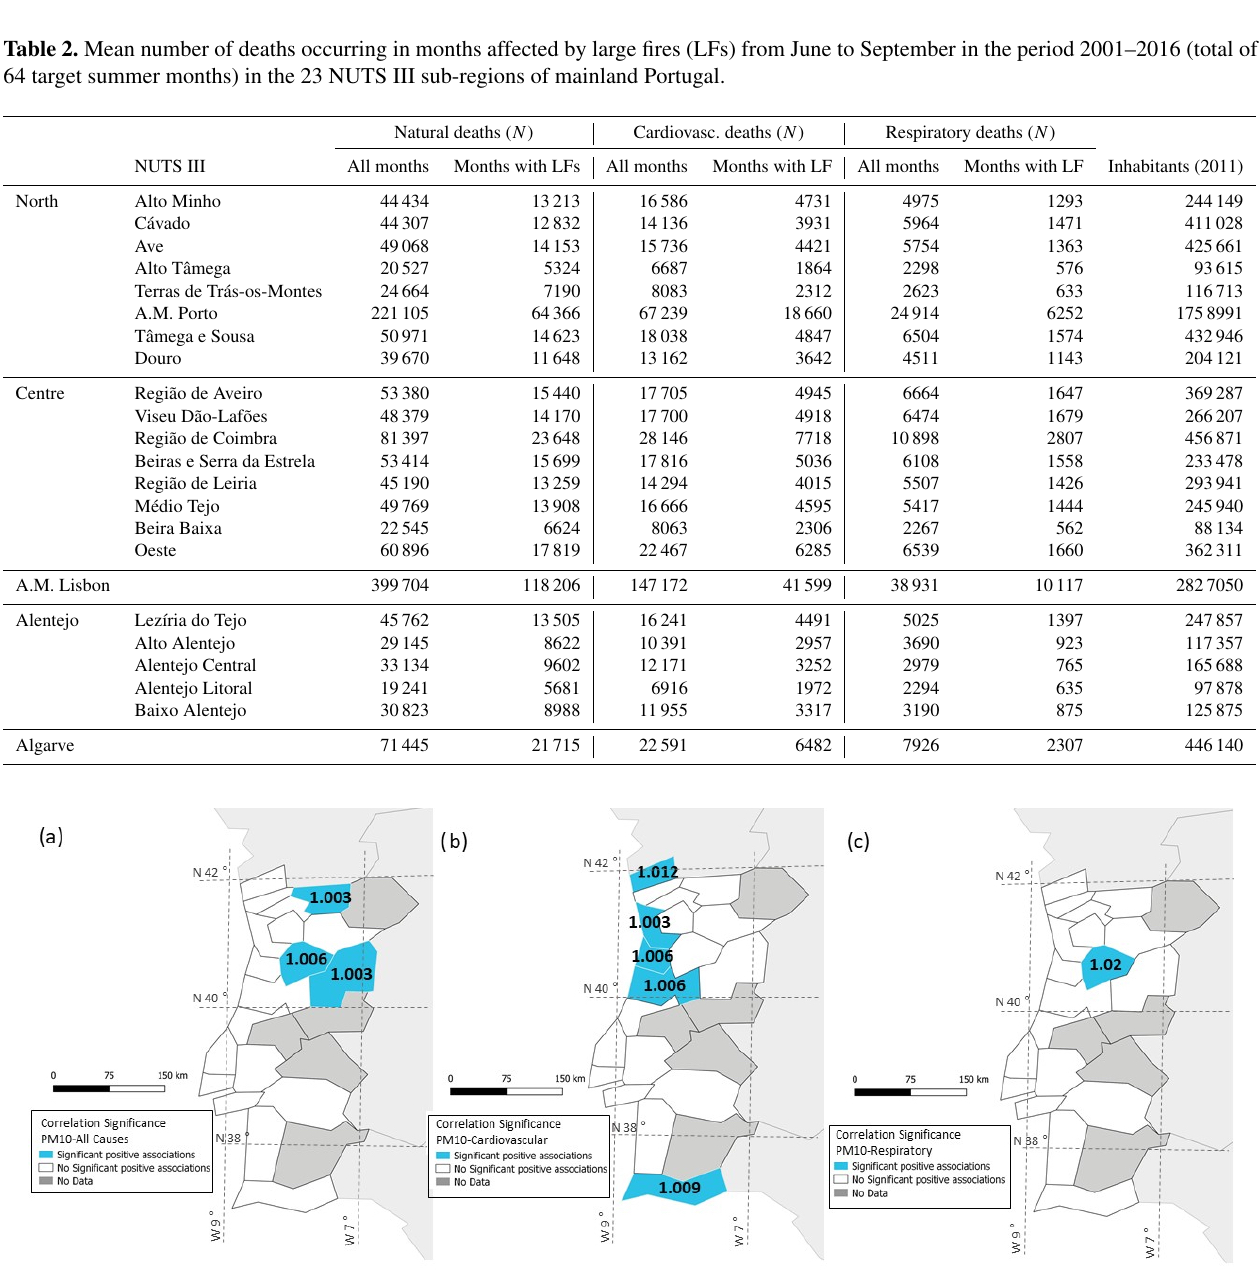
Figure 6. Relative risks (RRs, numbers) obtained from Poisson regression for PM 10 and (a) all-cause mortality, (b) cardiovascular mortality and (c) respiratory mortality from June to September in the period 2001–2016 (light blue NUTS III regions indicate a significant result, p < 0 . 05; white NUTS III regions present no significant results for the variables studied; grey NUTS III regions indicate that no data were available for correlations). Only significant RRs are